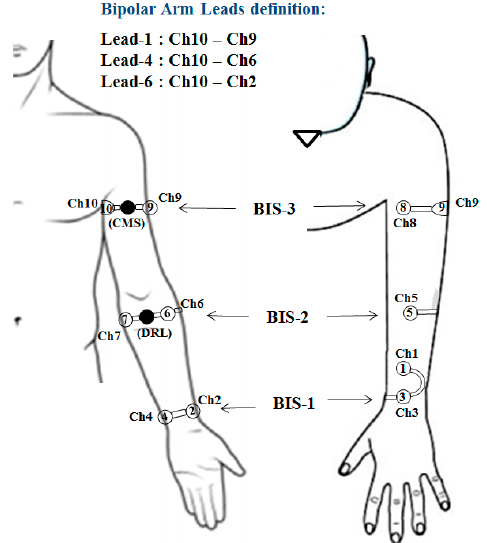
Figure 1. Suggested electrode locations for electrocardiographic signals (ECG) recovery along the left arm